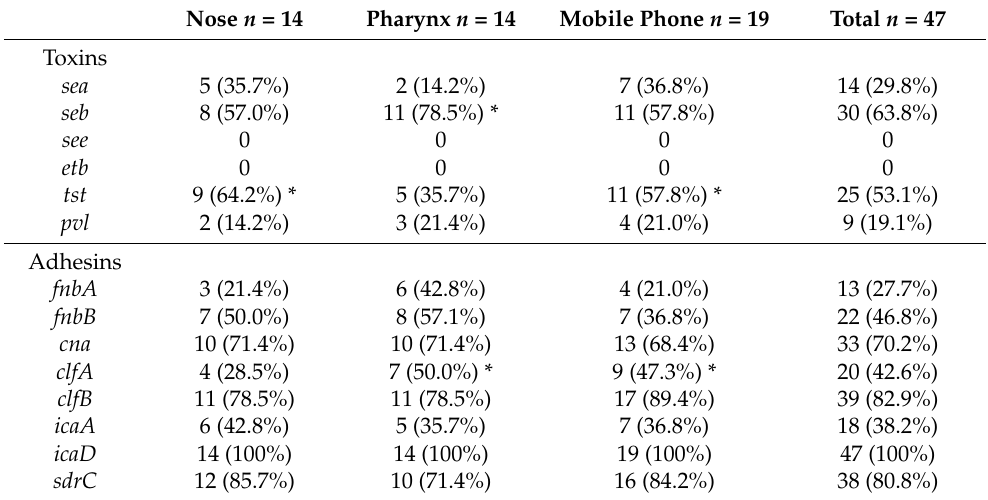
Table 3. Toxin and adhesin genes in Staphylococcus aureus strains isolated from students and their mobile phones.